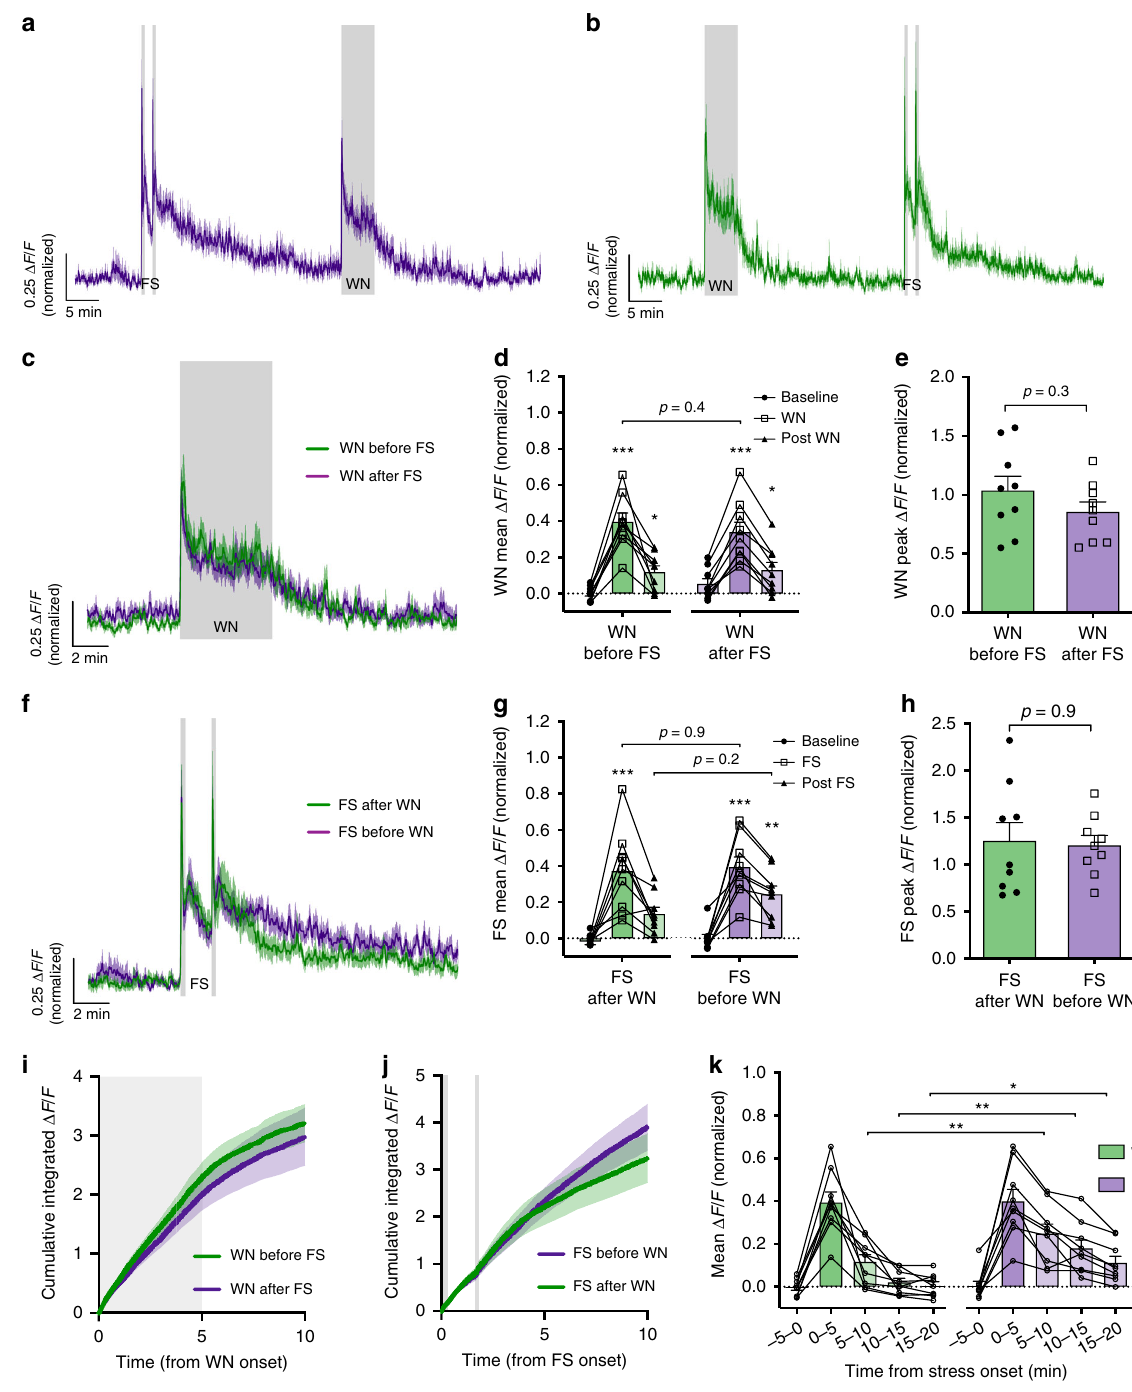
current clamp, CRH neurons were given a family of depolarizing neurons (Supplementary Fig. 4A, B). However, bath applied current steps after a single − 40 pA hyperpolarizing step (Fig. 6g). Fig. 4D, E) or PPR (Supplementary Fig. 4F). Likewise, bath exposed to WN stress had higher intrinsic excitability and a applied CORT also failed to inhibit electrical stimulation induced elevations in excitability in GCaMP6s-expressing CRH neurons 15 pA step onwards, n = 11 (Veh) and n = 12 (MET), RM two- (Supplementary Fig. 4G, H). way ANOVA; Fig. 6h). Input resistance was not different between We next examined whether in vivo CORT-negative feedback groups (Veh 1.50 ± 0.08 G Ω , n = 11 vs. MET 1.48 ± 0.10 G Ω , n = would alter the intrinsic excitability of CRH neurons in the 11, p = 0.9 unpaired t test; Fig. 6i). presence of AMPA (( + / − )- α -amino-3-hydroxy-5-methylisoxa- zole-4-propionic acid) and GABA A (gamma-aminobutyric acid [A]) receptor blockers. To measure intrinsic excitability in NATURE COMMUNICATIONS| (2019) 10:5696